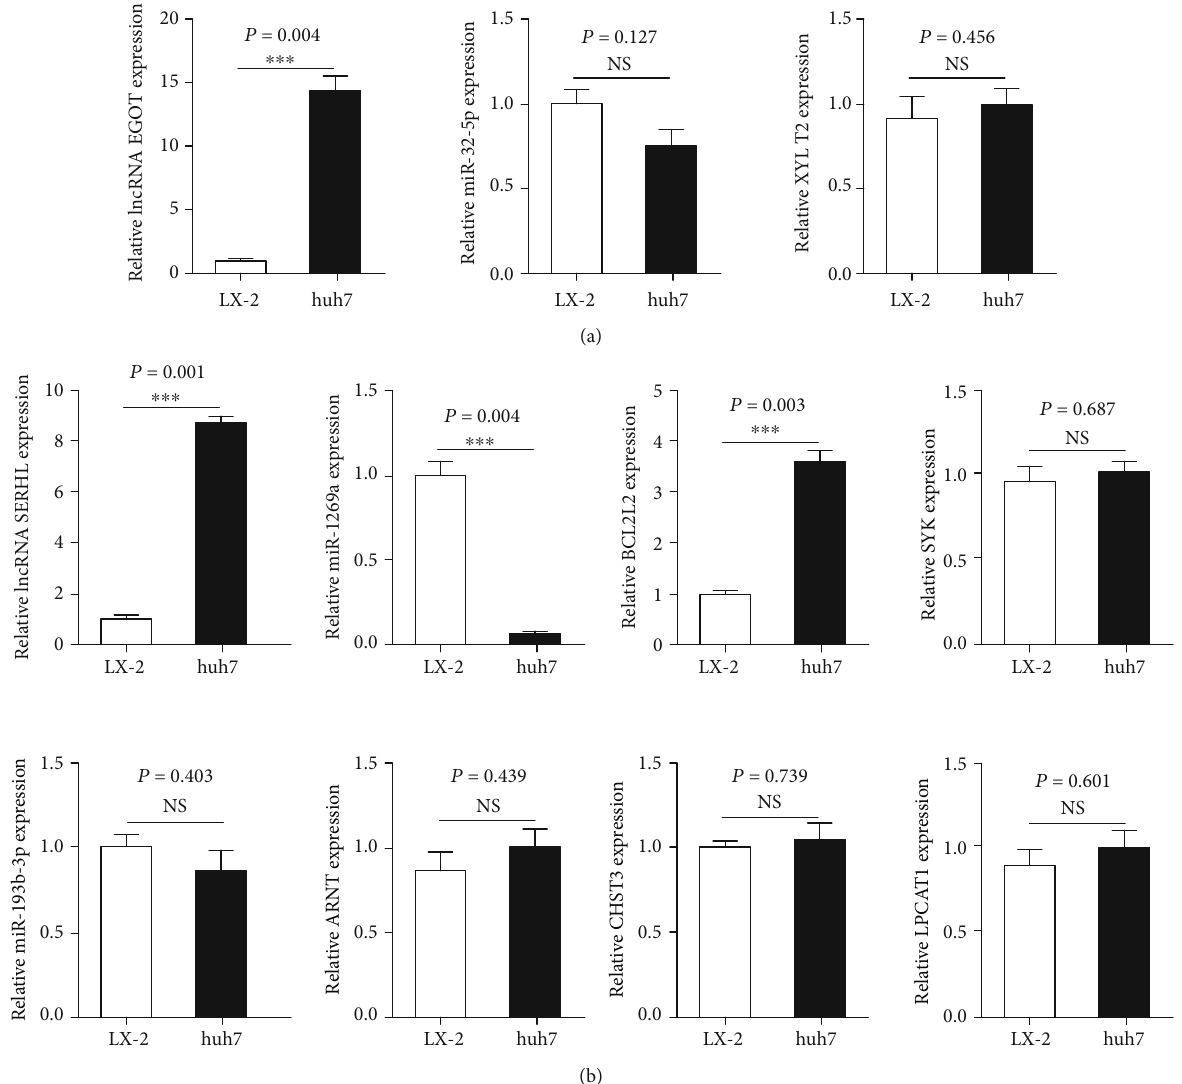
Figure 4: qRT-PCR validation of two key lncRNAs and their pair subnetworks in vitro studies. (a) Comparison of the expression levels of lncRNA EGOT-miR-32-5p-XYLT2 axis between Huh7 cells and LX-2 cells. (b) Comparison of the expression levels of lncRNA SERHL- miR-1269a/miR-193b-3p-BCL2L1/SYK/ARNT/CHST3/LPCAT1 axis between Huh7 cells and LX-2 cells. qRT-PCR: quantitative real-time polymerase chain reaction; lncRNA: long noncoding